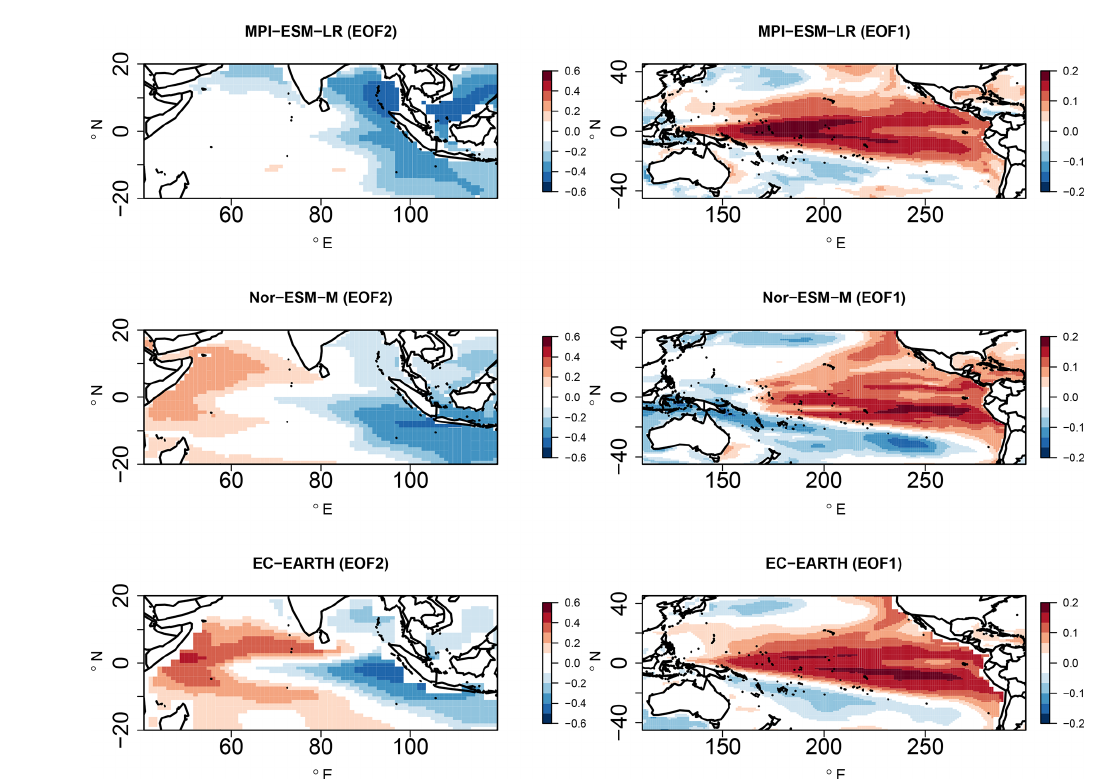
Figure 7. EOF2 patterns of SST anomalies (JJAS) in the Indian Ocean and EOF1 patterns (JJAS) in the Pacific Ocean for three GCM simulations, i.e., MPI-ESM-LR, Nor-ESM-M, and EC-EARTH, for the period of